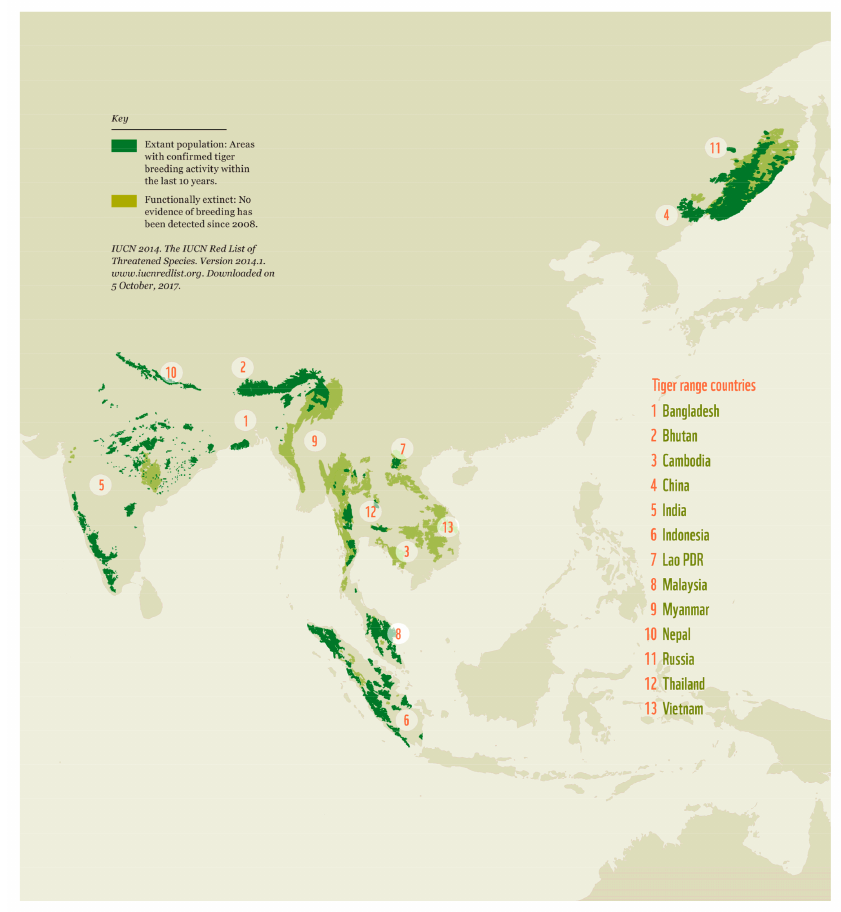
Figure 1. Distribution Range Wild